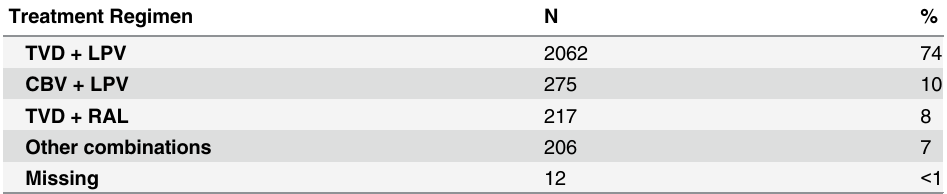
Table 2. PEP regimen prescribed (N = 2772). Treatment